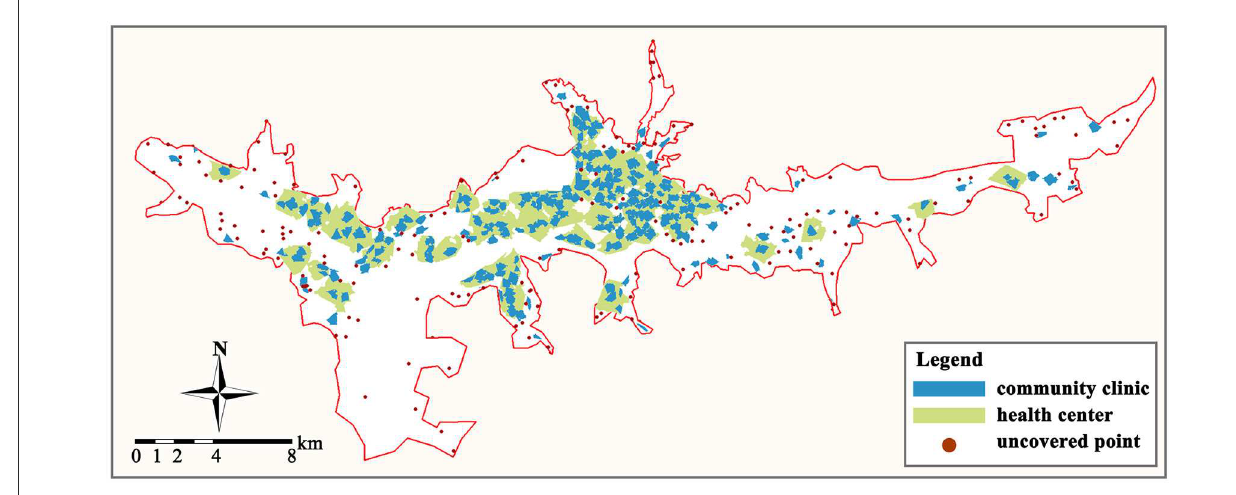
FIGURE9 Optimized primary care facility service area and uncovered residences.